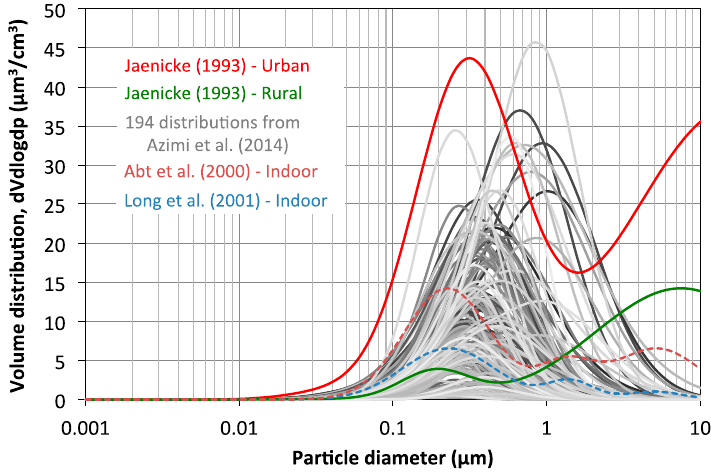
Figure 8. Residential indoor volume distributions for homes in Boston, MA, US from Abt et al. (2000)